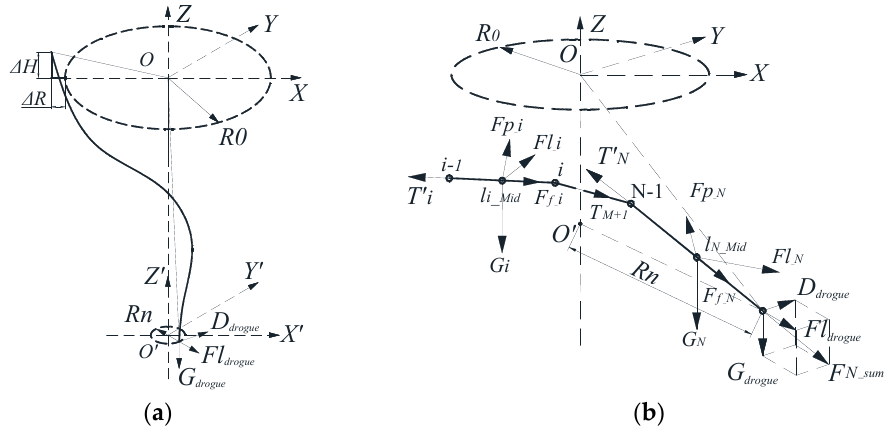
Figure 1. Hovering model of an airborne VLF antenna system: ( a ) the model of antenna spatial configuration; ( b ) the calculation of the model.